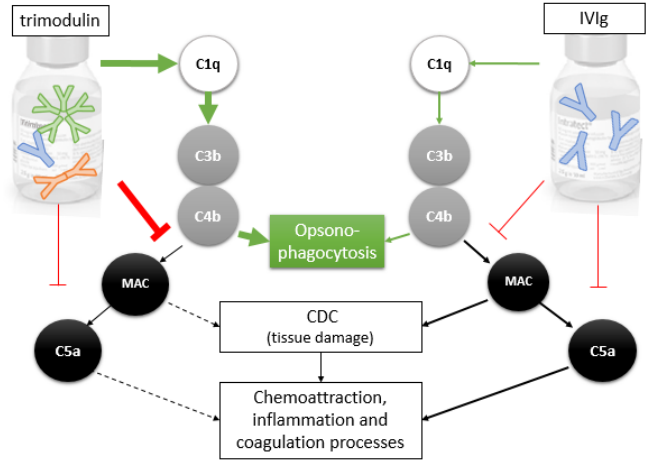
Figure 6. Interactions of trimodulin and IVIg with different complement factors in the classical complement pathway. Due to IgM content trimodulin activates the classical complement pathway effectively (bold green arrows) compared to IVIg (thin green arrows). This leads to effective C3b/C4b opsonization of pathogens, opsonophagocytosis and to pathogen clearance. Furthermore, trimodulin inhibits the downstream CDC pathway by reducing the formation of the MAC complex (bold red blocking line) more effectively as compared to IVIg (thin red blocking line) and consequently the release of toxic mediators released by pathogens, or in case of autoimmune diseases by the host cells. The release of toxins results in inflammation, as well as the recruitment of neutrophils, which secrete more inflammatory cytokines. Both inflammation and C5a release induce coagulation processes.